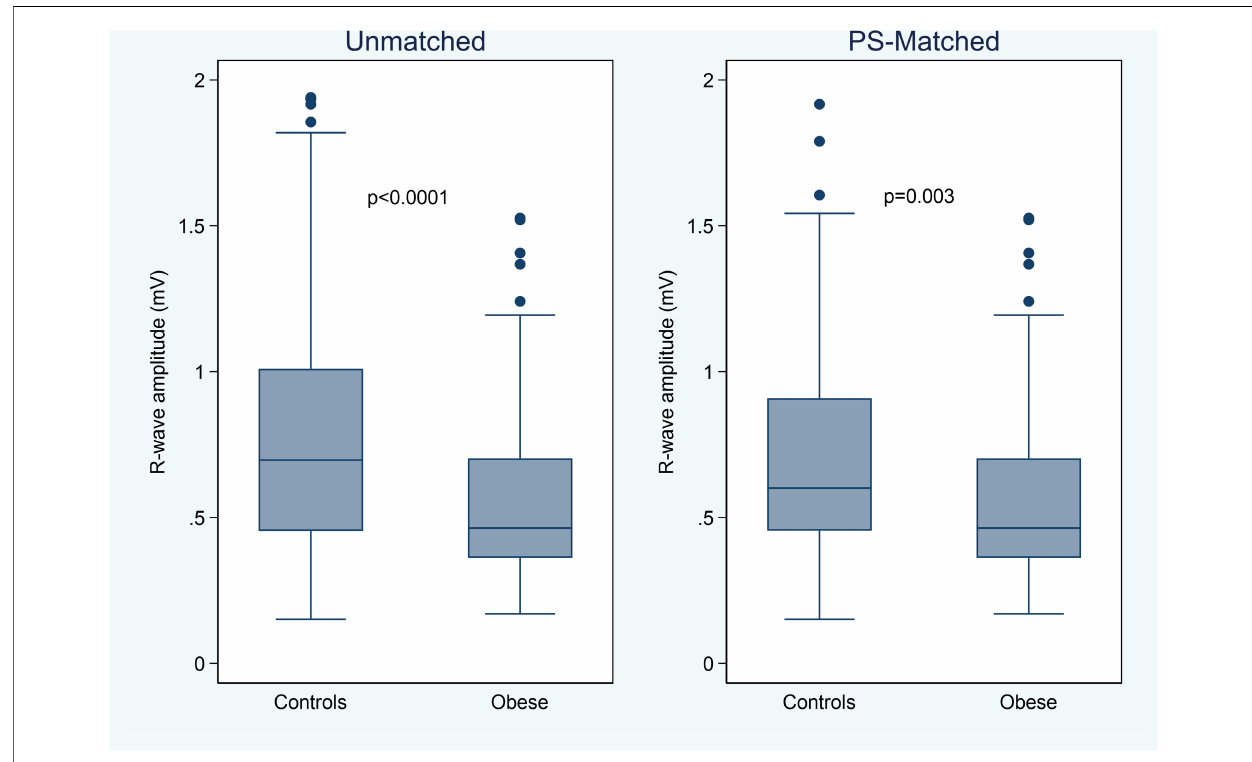
FIGURE 1 Box-whiskers plot of the 3-month average R-wave amplitude by study groups, in the unmatched and propensity score (PS) matched